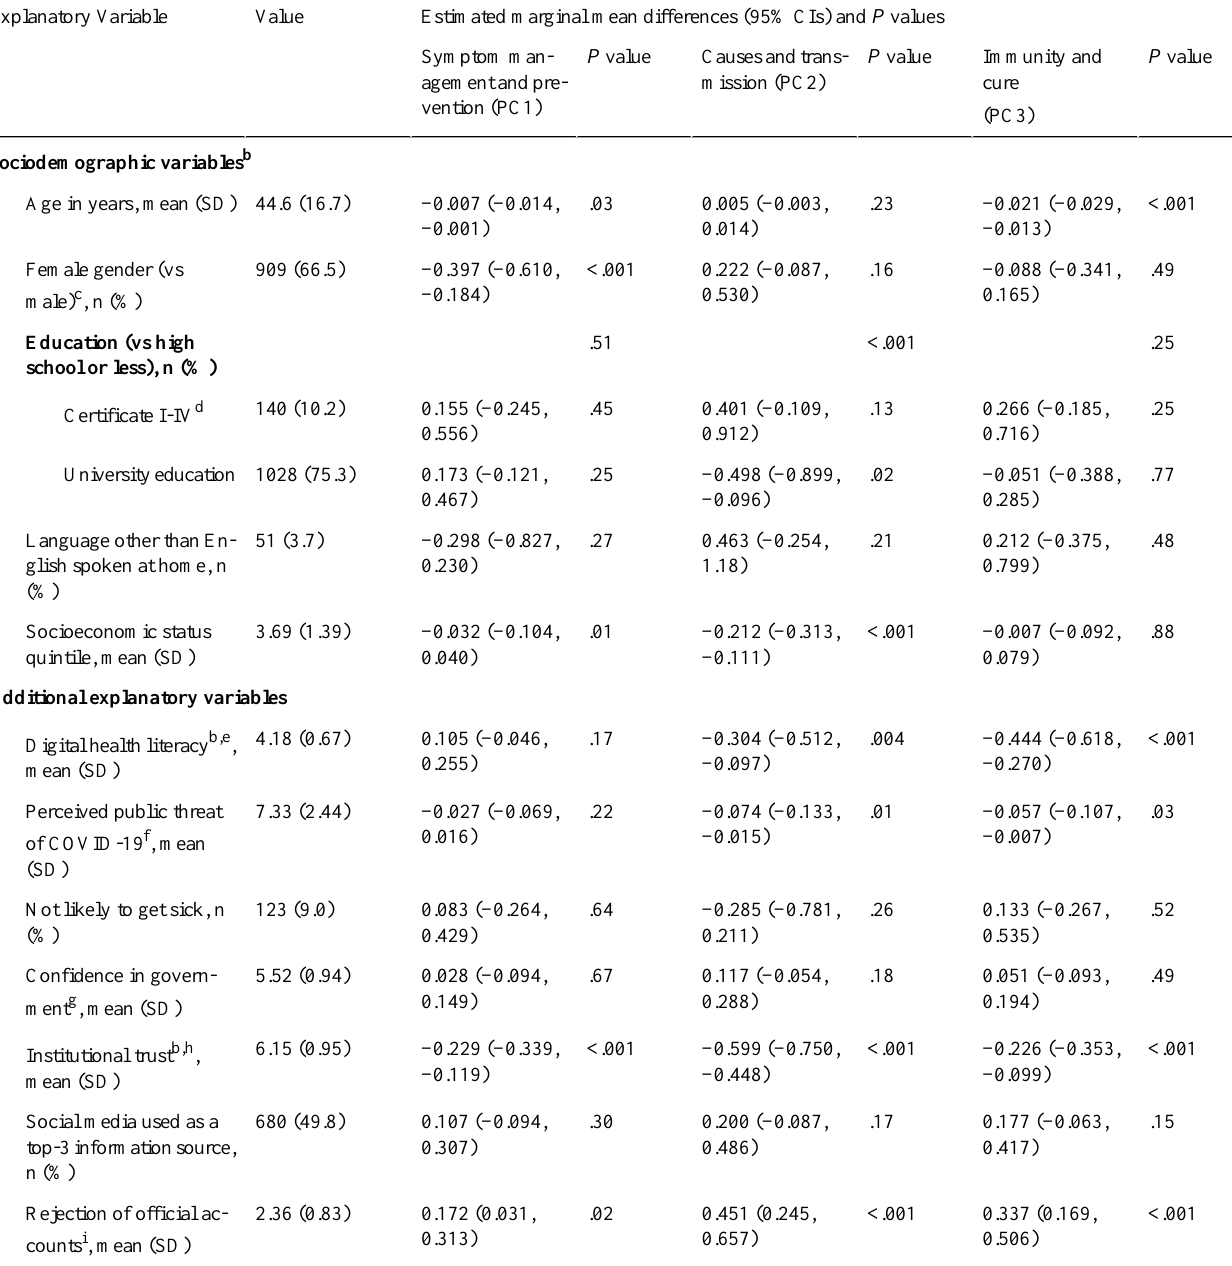
Table 5. Multivariable truncated linear regression of the misinformation beliefs in June (Round 3) a . Higher values of the outcome indicate greater support for these beliefs. Data are presented as estimated marginal mean differences (95% confidence intervals) and P